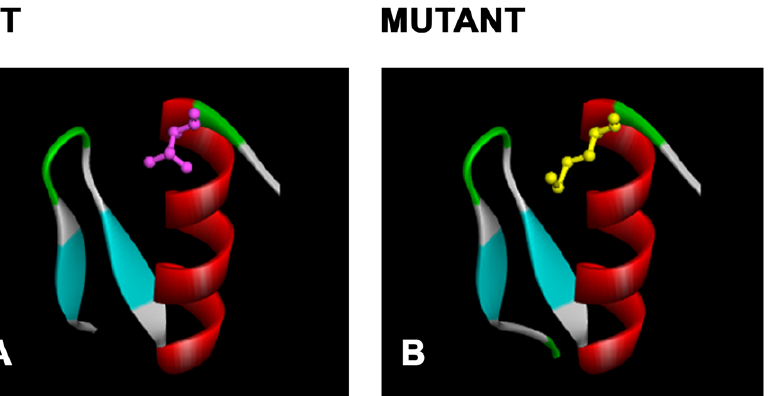
Figure 3. Molecular modeling of p.T443M in ZNF57. The zinc finger domain comprises two b -strands (blue) and one a -helix (red); the turns (green) and the loops (light gray) are shown. Amino-acid residue 443 is pink in the wild type (A) and yellow in the mutant (B).